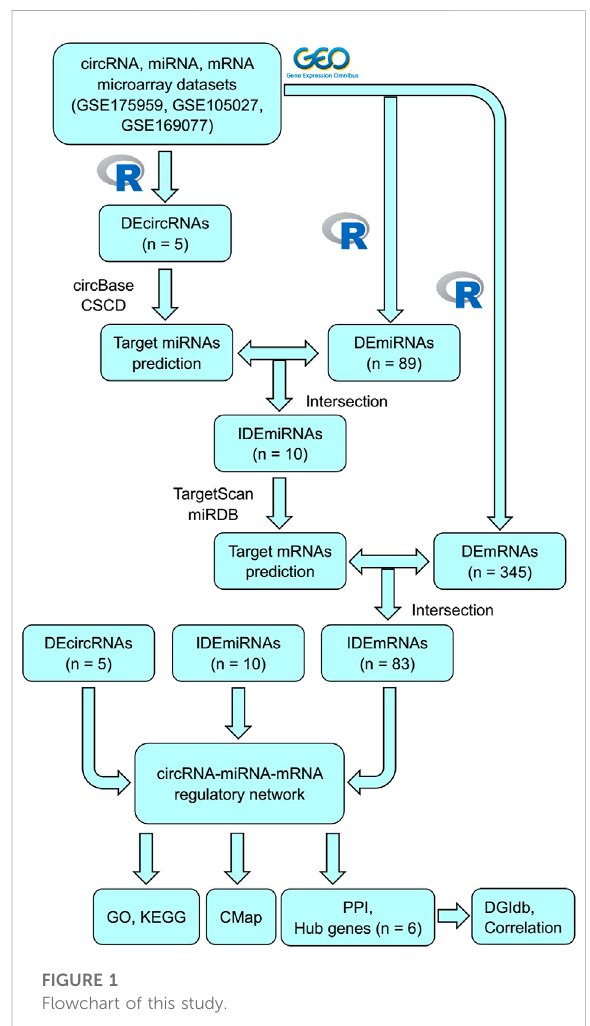
FIGURE 1 Flowchart of this